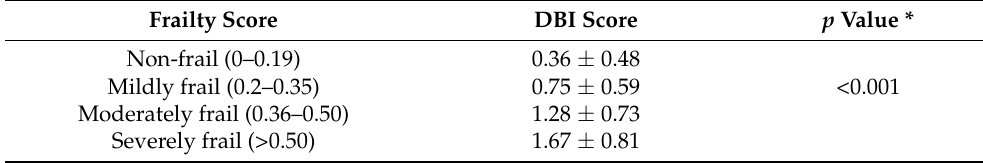
Table 2. Relation between frailty and DBI scores.